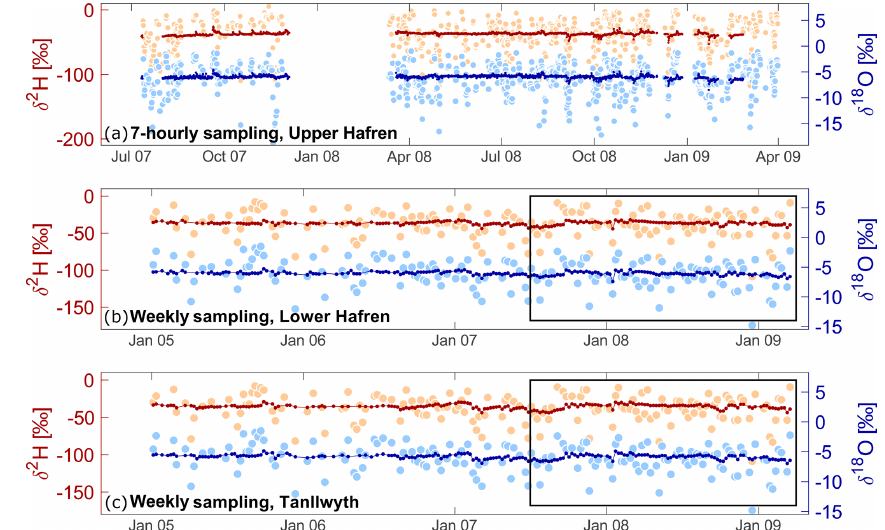
Figure 5. Time series of stable water isotopes measured at 7-hourly resolution (a) and weekly resolution (b–c) in precipitation (lighter colors) and streamwater (darker colors). All precipitation samples were collected at Carreg Wen, and 7-hourly streamwater samples were collected at the Upper Hafren catchment outlet, whereas weekly streamwater samples were collected at the Lower Hafren and Tanllwyth catchment outlets. The deuterium axis (left) is compressed by a factor of 8 relative to the oxygen-18 axis (right). Consequently, fluctuations along the meteoric water line would appear equally large for both isotopes. The black rectangles shown in the weekly plots indicate the period of the 7-hourly sampling.